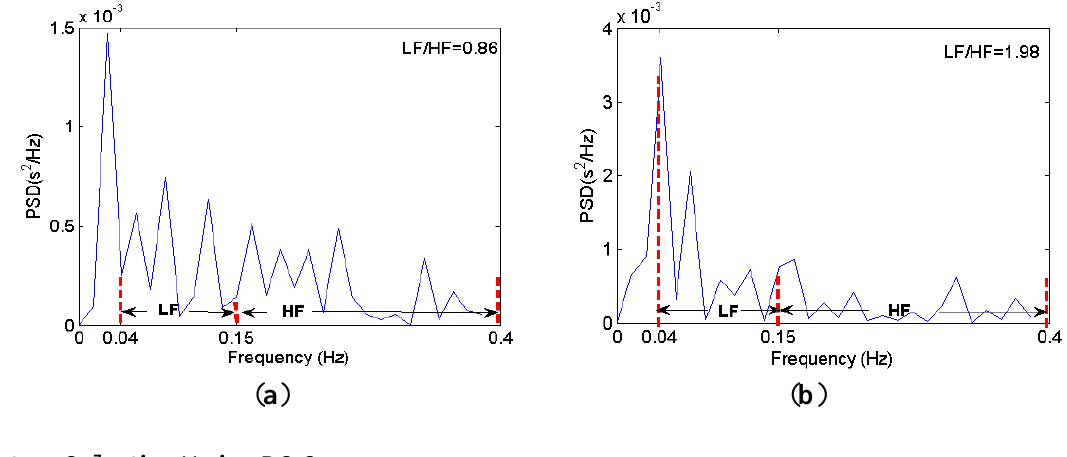
Figure 8. The typical LF and HF power spectrum computed by our server PC. ( a ) represents alert driving; ( b ) represents drowsy